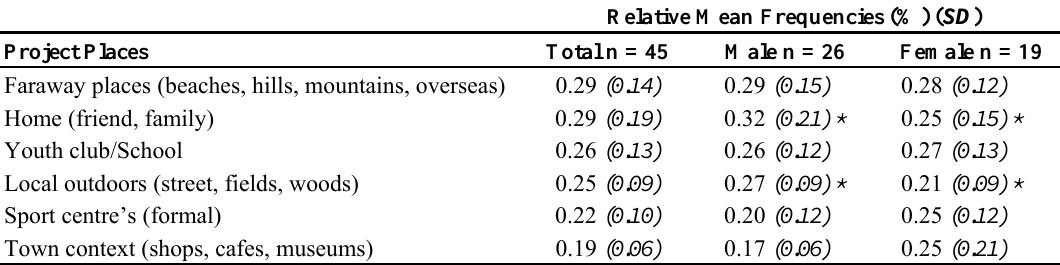
Table 3. Relative frequencies of project